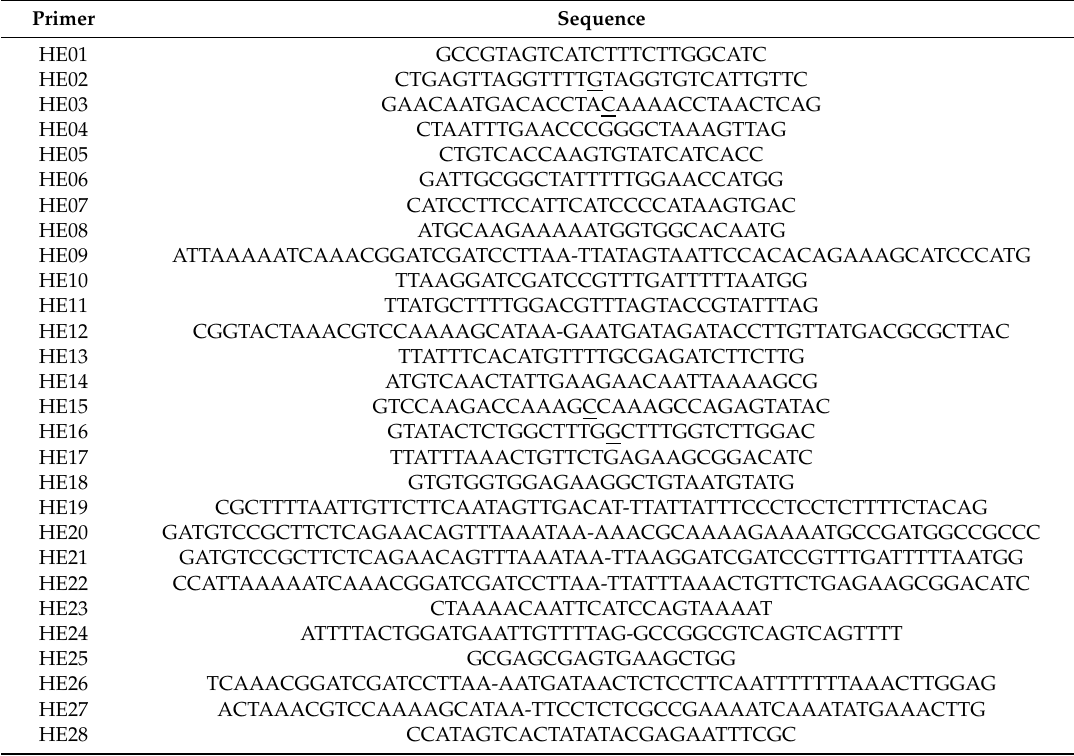
Table 3. Primers used in this study. Point mutations are